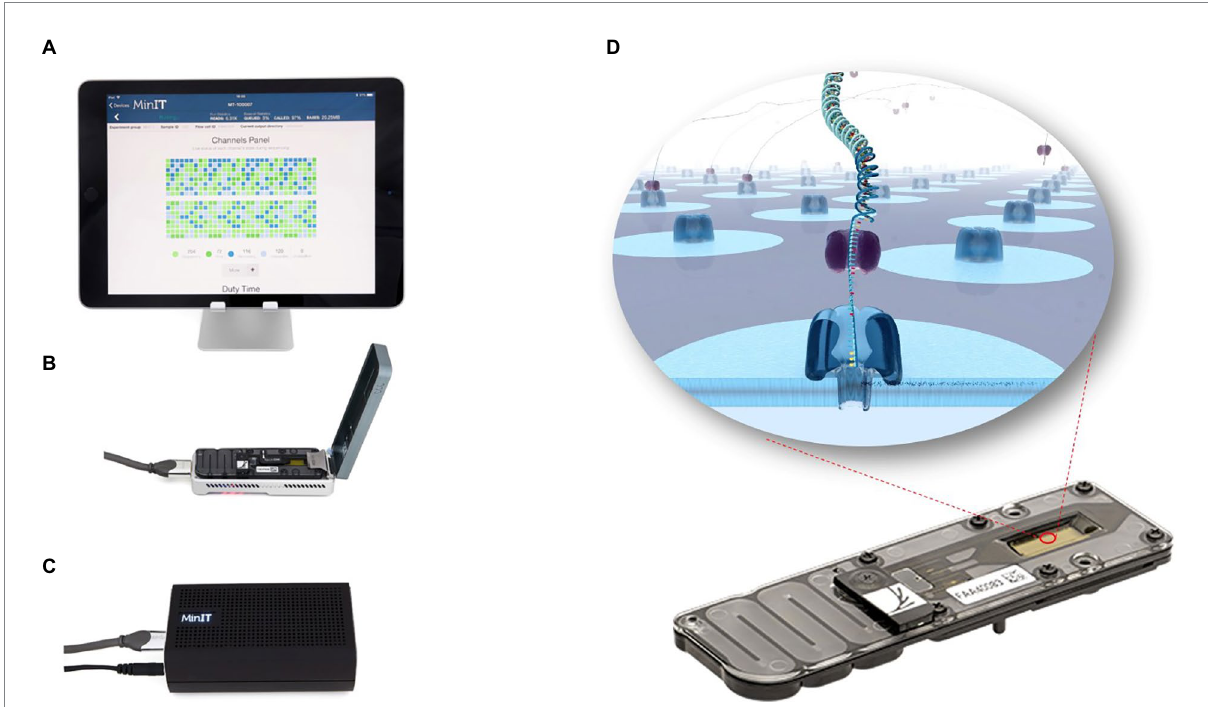
FIGURE 1 MinION sequencing device. MinION is a highly portable instrument (10 cm × 2 cm × 3.3 cm, about 90 g; B ). It can be connected to an ONTs “MinIT” decoder (C) or to any computer with a USB port (A) . The entire nanopore sequencing process and real-time data analysis can be done on a PC. Nanopore sequencing is achieved by adding a sequencing library to the flowCell sequencing chip (D) . When DNA or RNA molecules pass through the nanopore, there is a shift in the nanopore current, which is measured by a sensor. The data is further transmitted and decoded into base signals that determine the nucleic acid